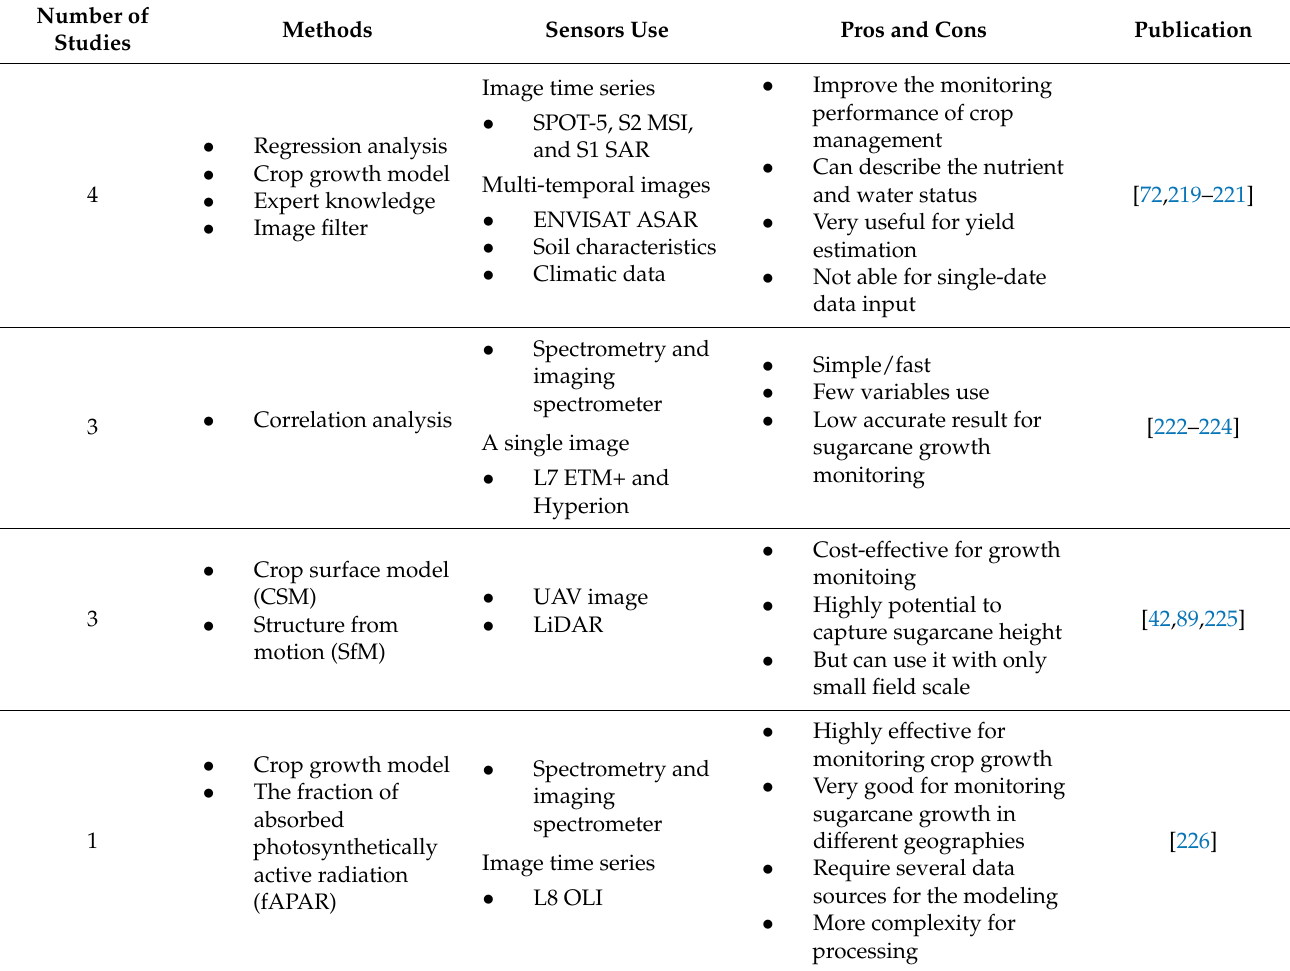
Table 5. Summary of the number of studies, different methods, data used, and pros and cons for growth anomaly monitoring. Number of Studies